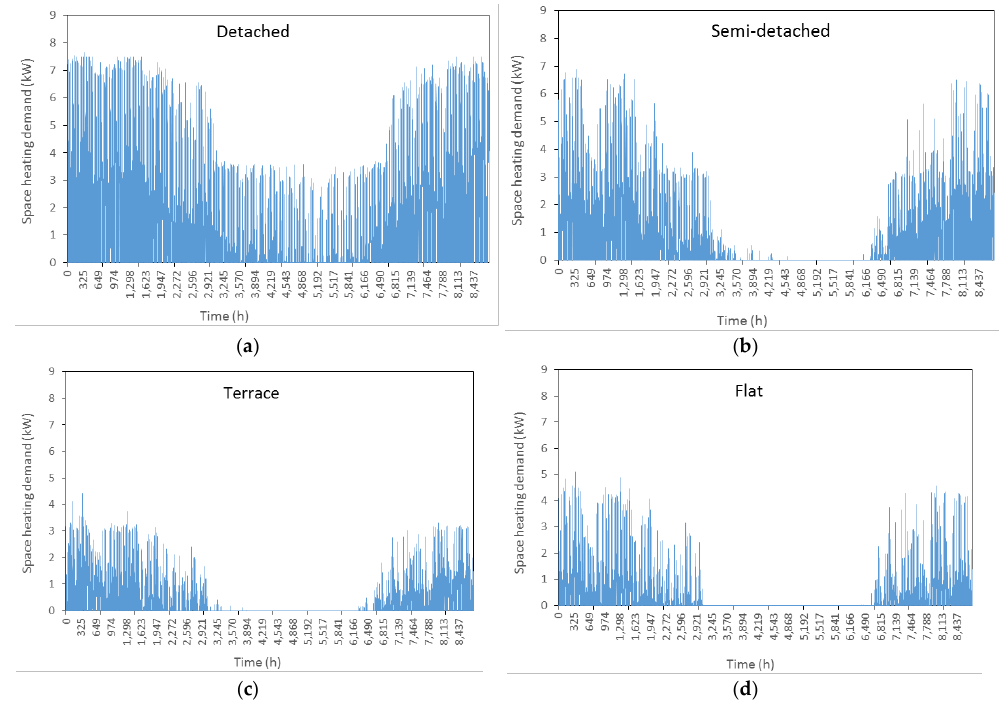
Figure 2. Space heating demand for all house types: ( a ) Detached; ( b ) Semi-detached; ( c ) Terrace; ( d ) Flat.